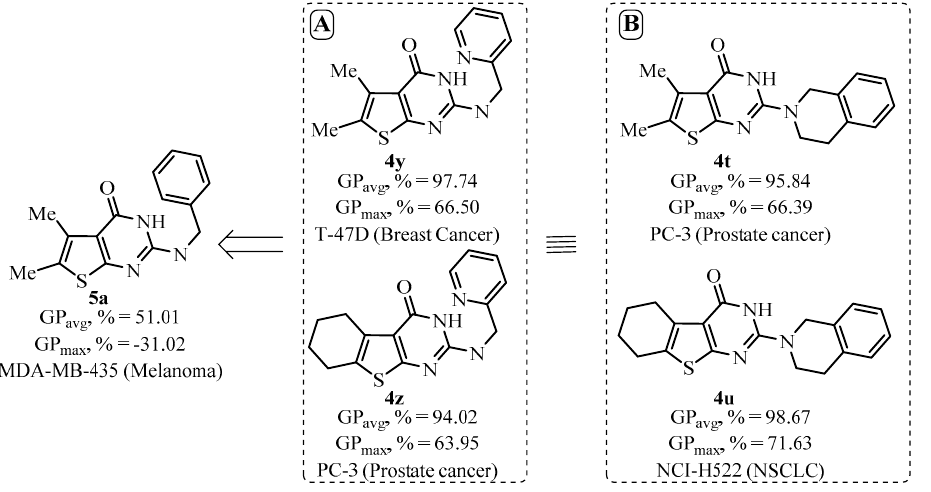
Figure 6. Structure–activity relationship among thieno[2,3- d ]pyrimidines; influence of hindering of free rotation in the residues bearing pyrimidine ring. ( A ) Thieno[2,3- d ]pyrimidines with pyridin-2-